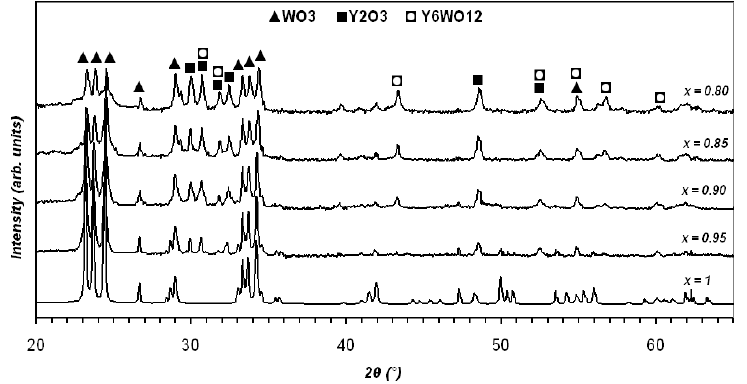
Figure 2. XRD analysis of mixed powder for x = 1, 0.95, 0.9, 0.85, and